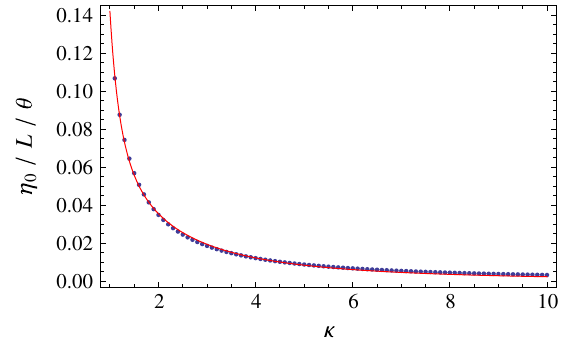
= ð L(cid:4) Þ for minimum EME emit- FIG. 15. Initial dispersion (cid:6) 0 tance. The red curve is given by the approximate expression 0 : 298 =(cid:12) 4 (cid:1) 0 : 448 =(cid:12) 3 þ 0 : 292 =(cid:12) 2